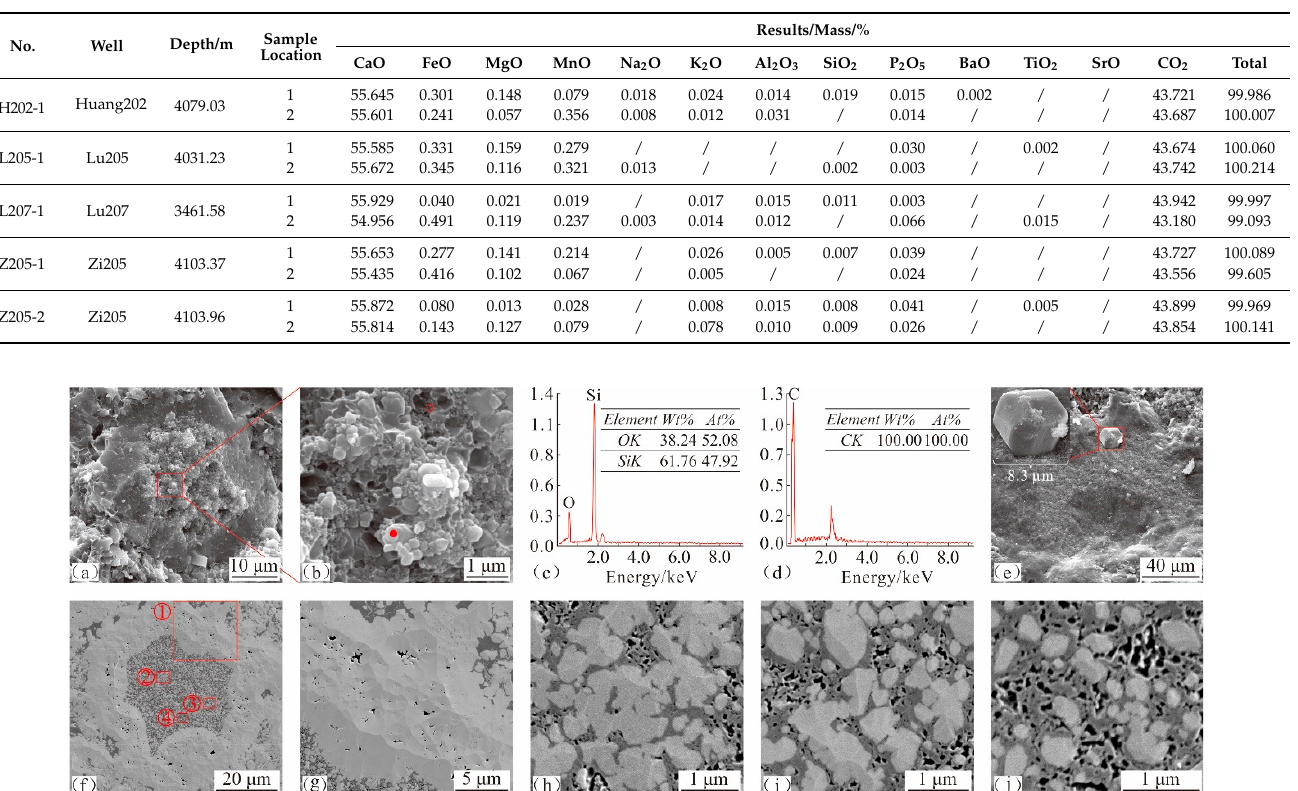
( d ) Complete radiolarian siliceous shell, filled with pyrite and organic–silicon complex. ( e ) Complete radiolarian siliceous shell, filled with calcite (white) and organic–silicon complex (black). ( f ) Spectral image of radiolarian siliceous shell on the left of image ( e ). ( g ) The scanned silicon element of image ( f ). ( h ) The scanned carbon element of image ( f ). ( i ) Spectral image of radiolarian siliceous shell on the right of image ( e ). ( j ) The scanned silicon element of image ( i ). ( k ) The scanned calcium element of image ( i ). ( l ) The scanned carbon element of image ( i ). ( a , e ): Plain light. ( b – d , f , i ): Spectral image. ( g , h , j – l ): Element scanning. Table 2. In situ detected chemical compositions of calcites in radiolarian siliceous shell cavities.